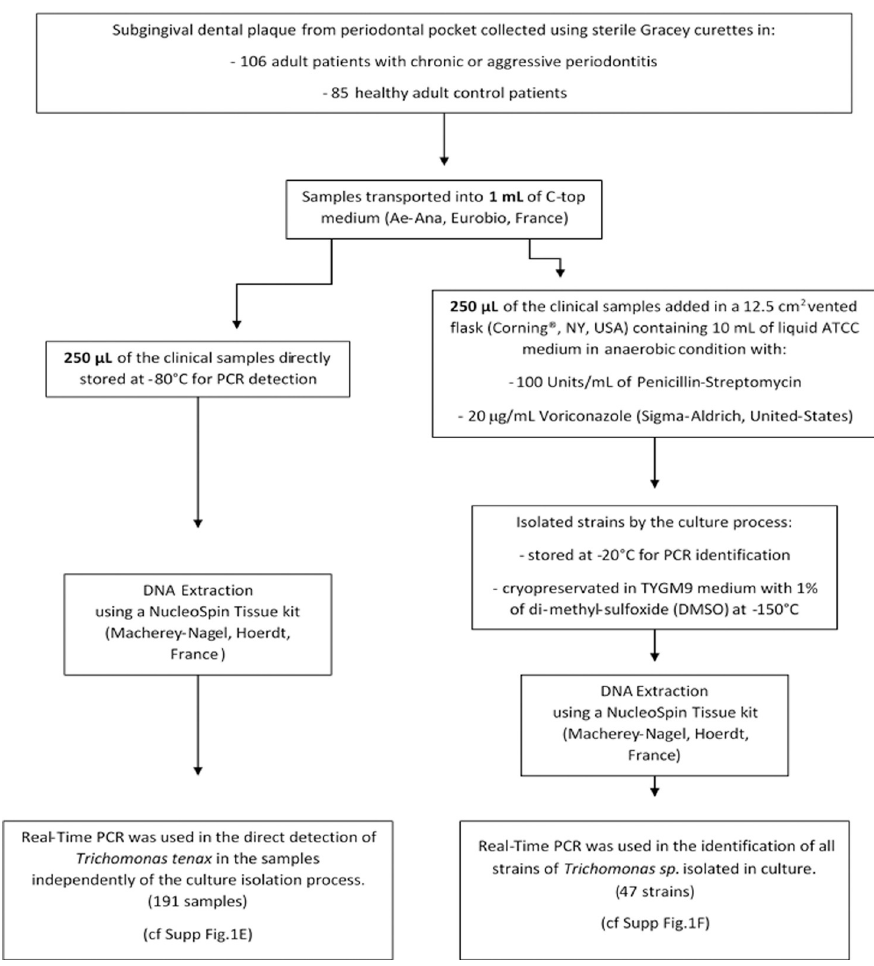
Fig 1. Schematic protocol for Trichomonas tenax